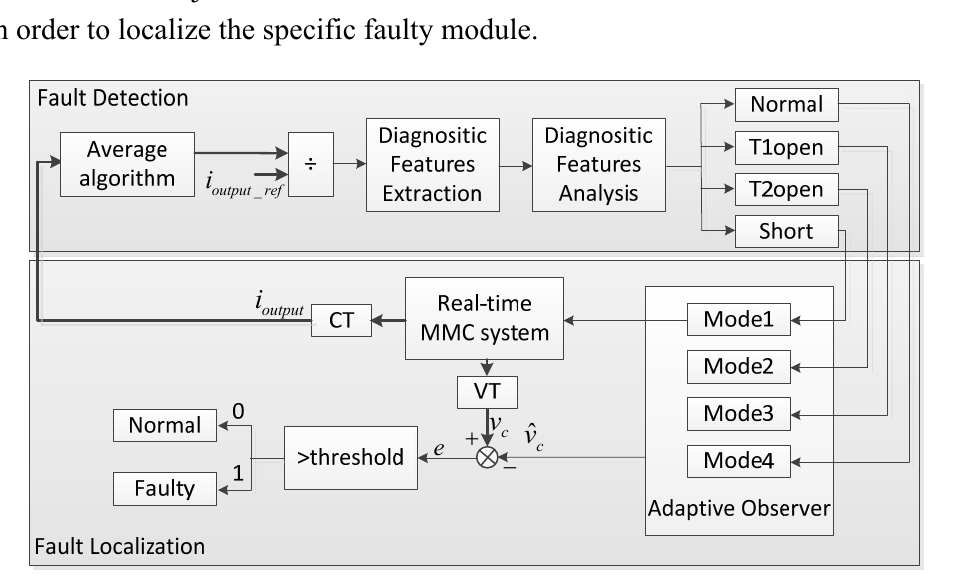
Figure 4. Framework of the proposed identification